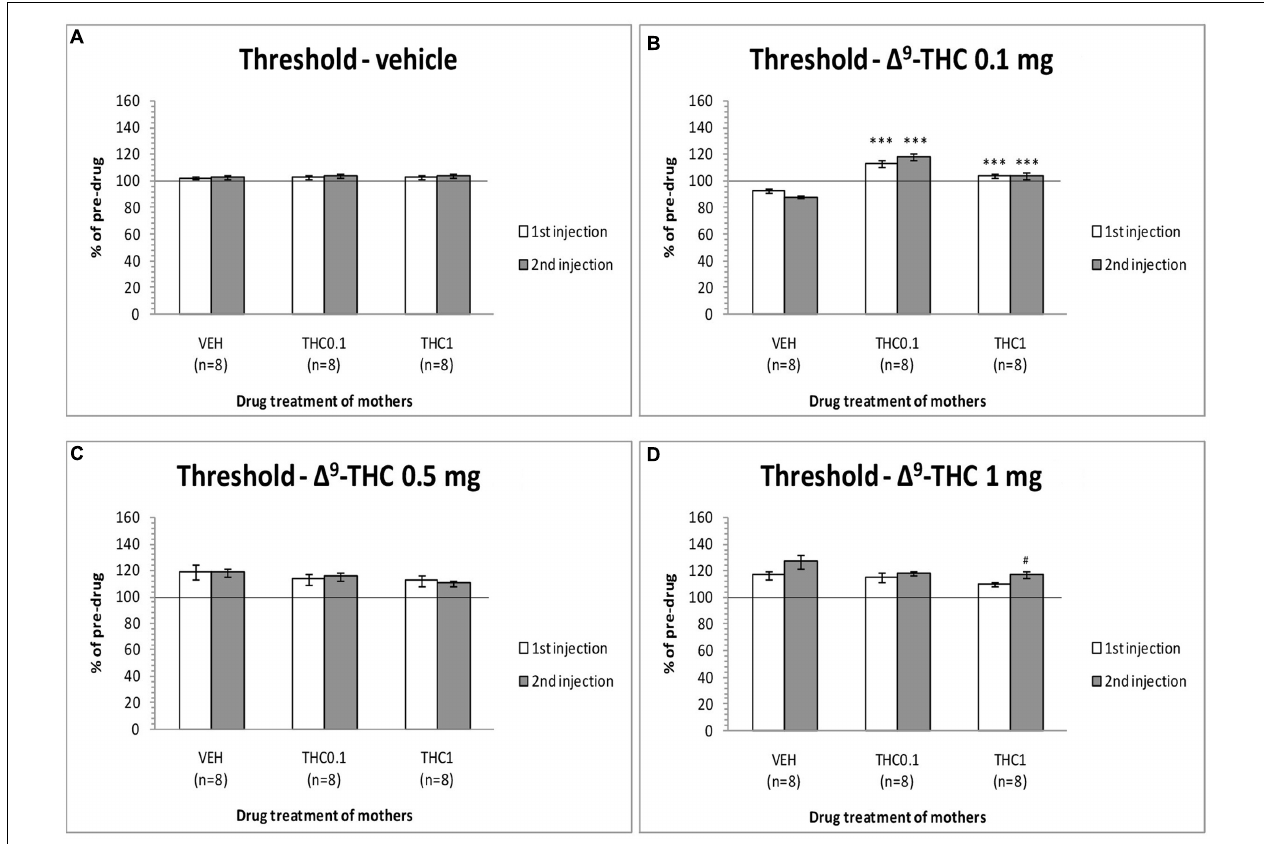
FIGURE 2 | Changes in self-stimulation threshold in F1 animals, expressed as percentage of predrug value, following acute i.p. administration of 0 mg/kg (A) , 0.1 mg/kg (B) , 0.5 mg/kg (C) , and 1 mg/kg (D) of (cid:49) 9 -THC, during first and second postinjection session. Horizontal axes represent the three groups of F1 animals. The asterisk ( ∗ ) signifies a statistically significant effect compared to the vehicle group (F1 of F0-VEH animals), ∗∗∗ p < 0.001. # signifies a statistically significant effect compared to the first postinjection of the same group, # p <